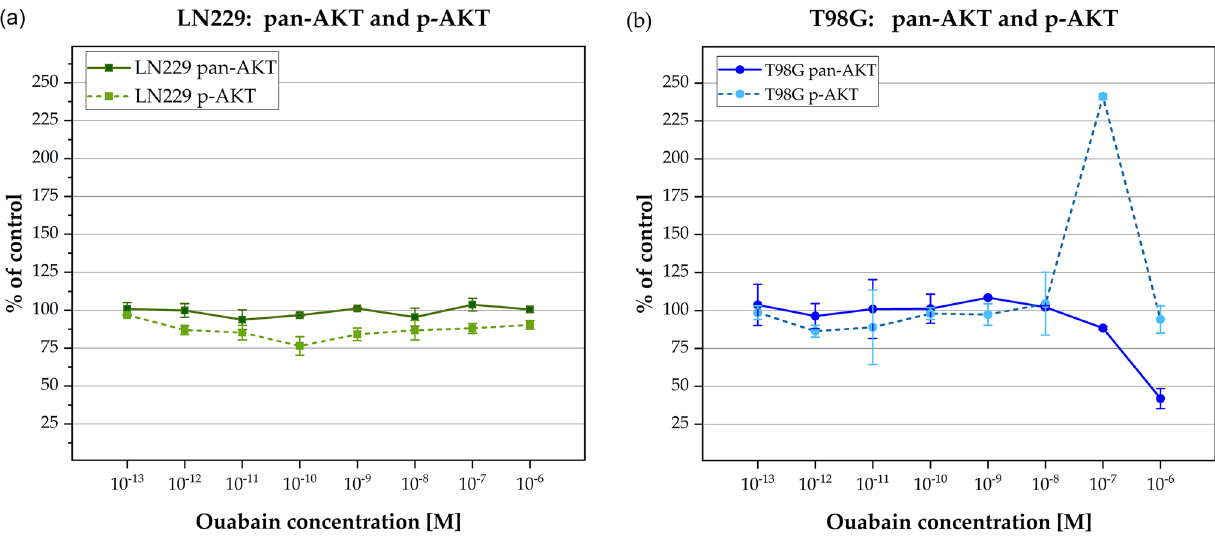
Fig. 8 Akt activation in cell line LN229 ( a ) and T98G ( b ). The pan-Akt (dark points/line) and p-Akt (light points/dashed line) activation (% of control) was plotted as the function of the Ouabain concentration (10 –13 to 10 –6 M) after 24 h treatment. A significant change was only observed for the TMZ-resistant cell line T98G with an increase of p-Akt at 0.1 µM Ouabain and a decrease of pan-Akt at 1 µM. Error bars rep- resent the range of measured values. OD -values were presented in % of vehicle control (= 450-540